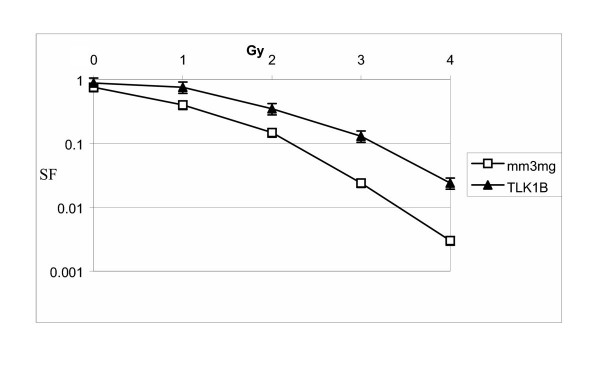
Pattern of γ-radiation sensitivity by clonogenic assays. 104 untransfected MM3MG and cells overexpressing TLK1B were irradiated with the indicated doses and plated in triplicates of 100, 500, 1000, or 5000 cells in multiwell plates. The colonies were counted 10 days later. The average from 2 independent experiments is shown. S.F. = surviving fraction.